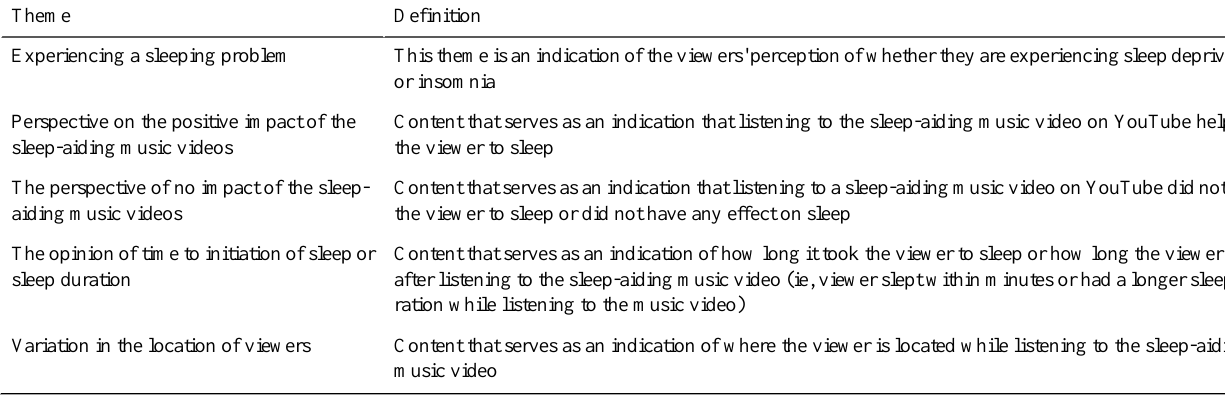
Table 2. Classification of themes from YouTube sleep-aiding music video comments.